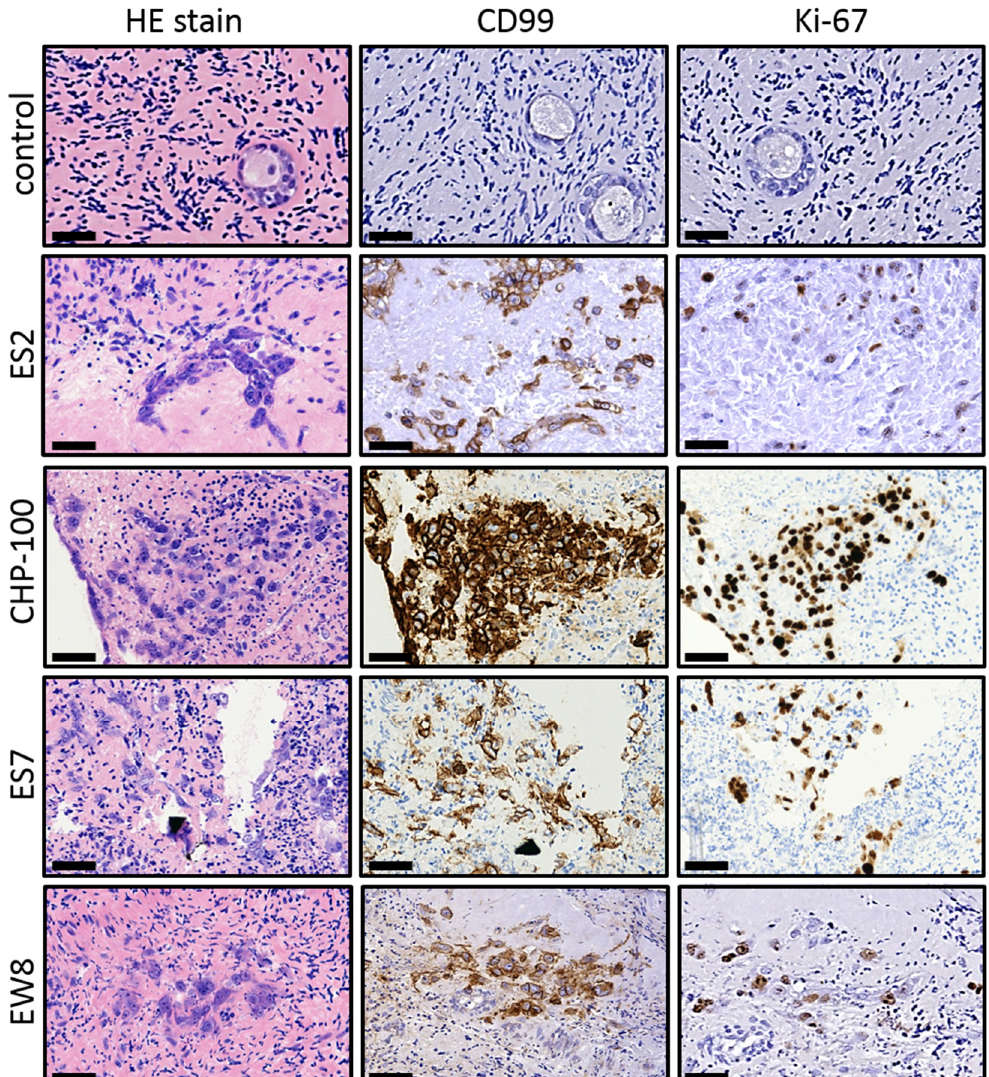
Figure 2. Establishing an organ culture system harboring tumor foci of Ewing’s sarcoma. After introduction into human ovarian cortex tissue followed by 4 days of culture, cells of ES2, CHP-100, ES7 and EW8 formed small tumor foci that could be easily distinguished from the surrounding ovarian tissue by standard HE staining. Staining for the membrane protein CD99, a marker for ES that is not expressed in ovarian cortex tissue (control), revealed that malignant cells were capable of establishing new tumor foci at distant sites during culture. Part of the ES cells were positive for the Ki-67 proliferation marker, indicating that tumor foci were still growing at the end of the culture period. Bars indicate 25 µm. EW, Ewing; HE, Hematoxylin Eosin; CD, cluster of differentiation.